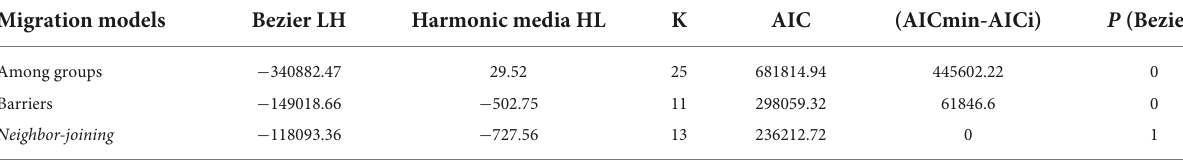
TABLE 4 Migration’s model and no. of migrants between